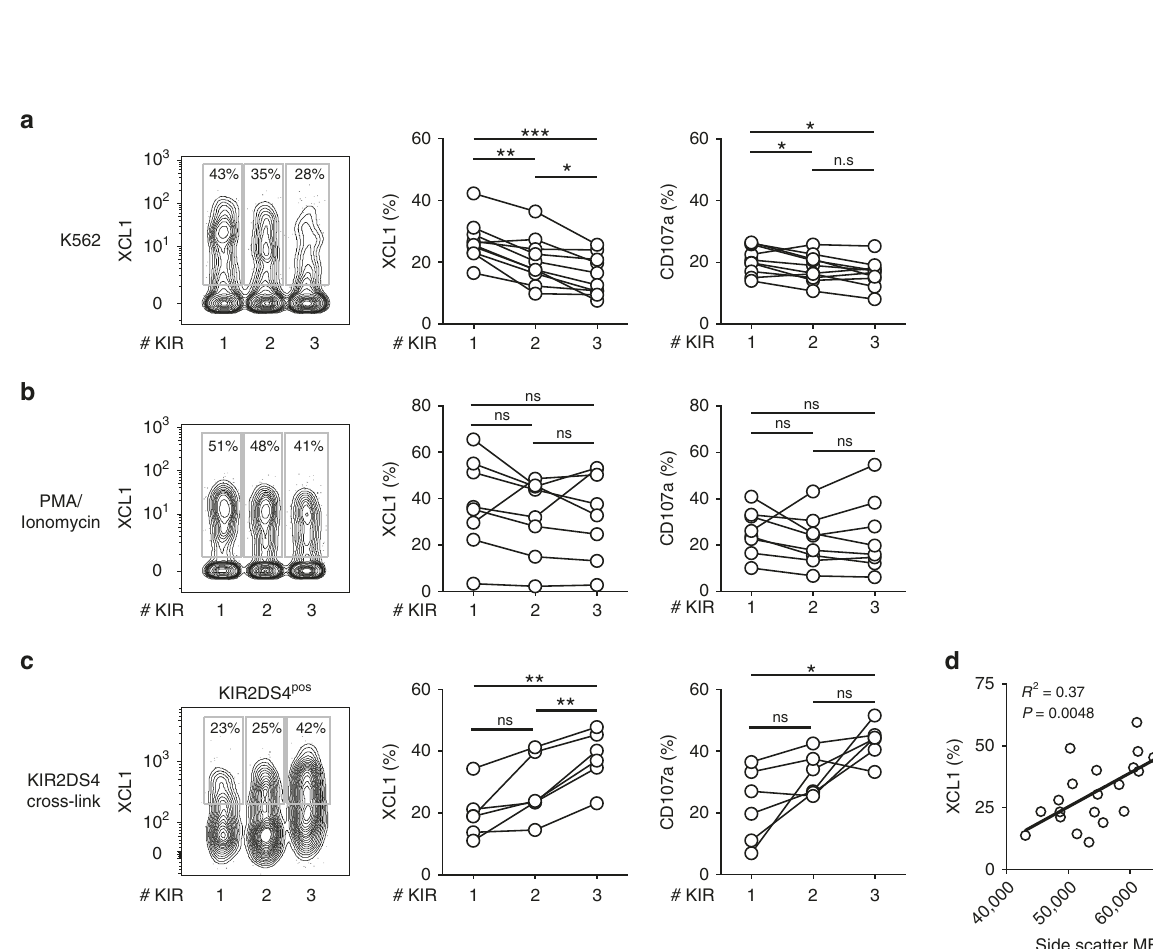
Fig. 6 dNK responses triggered by activating KIR. a Representative XCL1 and CD107a staining by CyTOF in lineage negative (Lin − ) CD56 + decidual cells co-expressing 1 – 3 Killer-cell immunoglobulin-like receptors (KIR) following a 6 h co-culture with K562 ( n = 10). b Representative XCL1 and CD107a staining by mass cytometry in Lin-CD56 + cells co-expressing 1 – 3 KIR following 4 h stimulation by PMA plus ionomycin ( n = 8). c Representative XCL1 staining by fl ow cytometry in Lin-CD56 + KIR2DS4 + decidual cells co-expressing 1 – 3 additional KIRs following activation via P815 cells coated with anti-KIR2DS4 ( n = 6). d Correlation of frequency of XCL1 + Lin-CD56 + decidual cells and mean side scatter for the same subset ( n = 20). Two-tailed